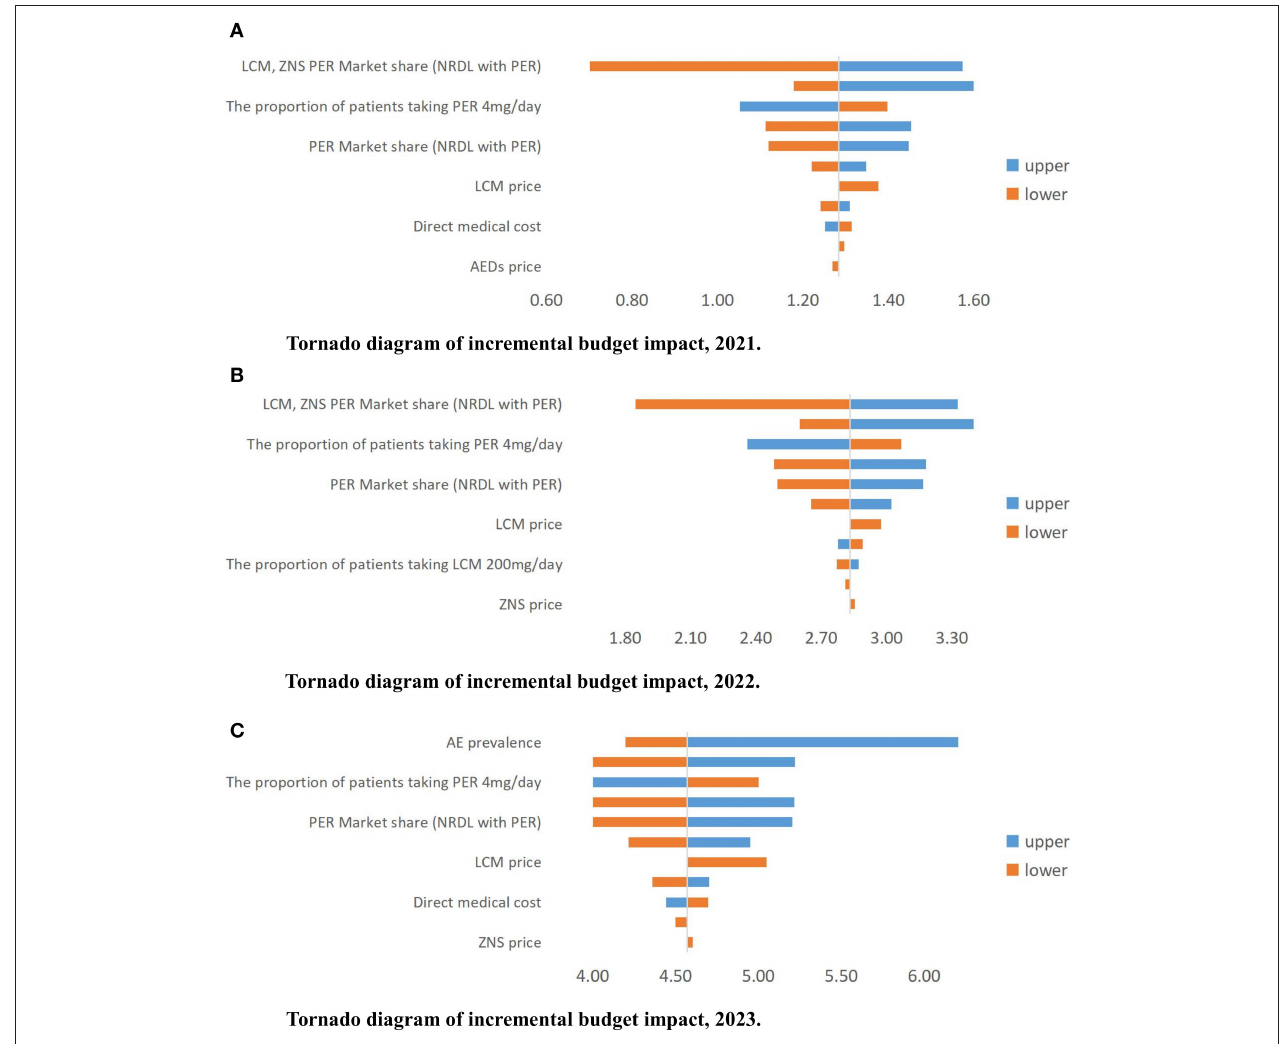
FIGURE 6 | (A–C) Tornado diagram of incremental budget impact, 2021–2023 (million USD). AE, active epilepsy; PER, perampanel; LCM, lacosamide; ZNS, zonisamide; NRDL, National Reimburesement Drug List; AED, antiepileptic